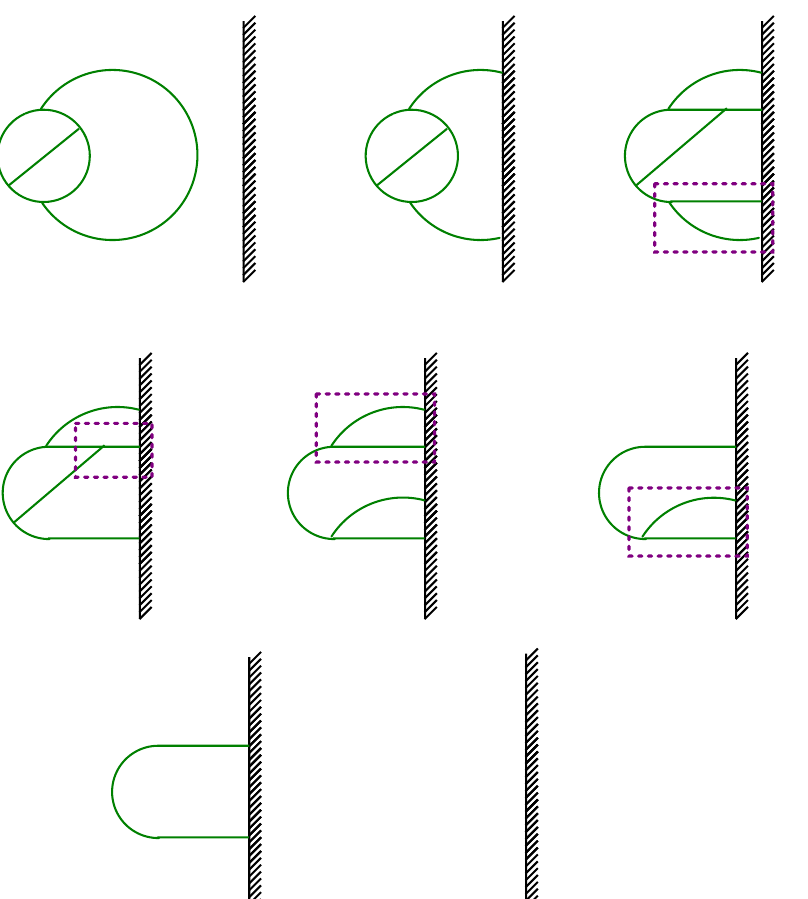
Figure 2 . The argument for theorem 3 illustrated for D = 2 . At top left we have the special bubble introduced near the boundary. From left to right, top to bottom, this bubble is absorbed by the boundary. In purple we have indicated where absorbing a point-like junction causes a recombination of the boundary defects, and produces compensating phases. The condition that the boundary correlation function is non-vanishing requires that these phases precisely cancel e 2 πiω of the original bubble. This requires ω be exact in group cohomology, hence that there is no